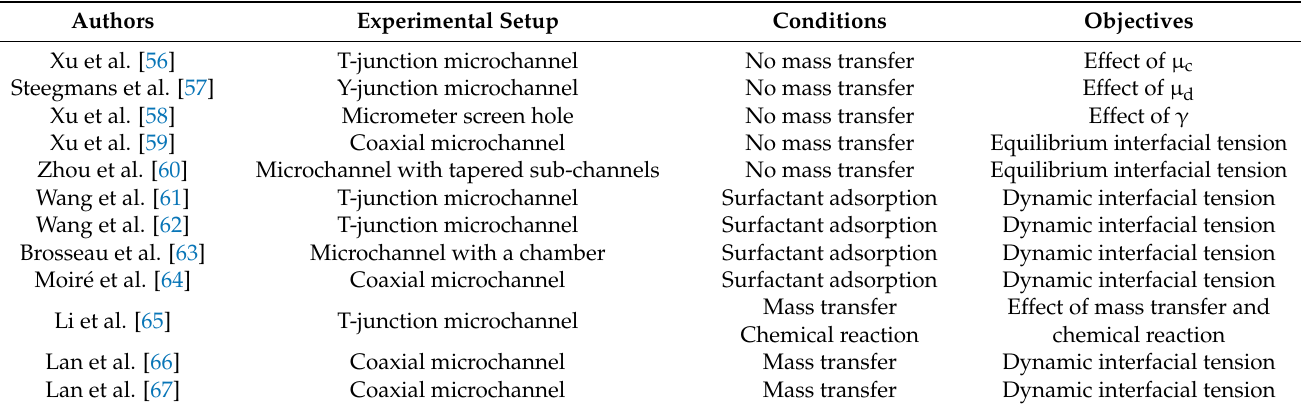
Table 4. Studies on